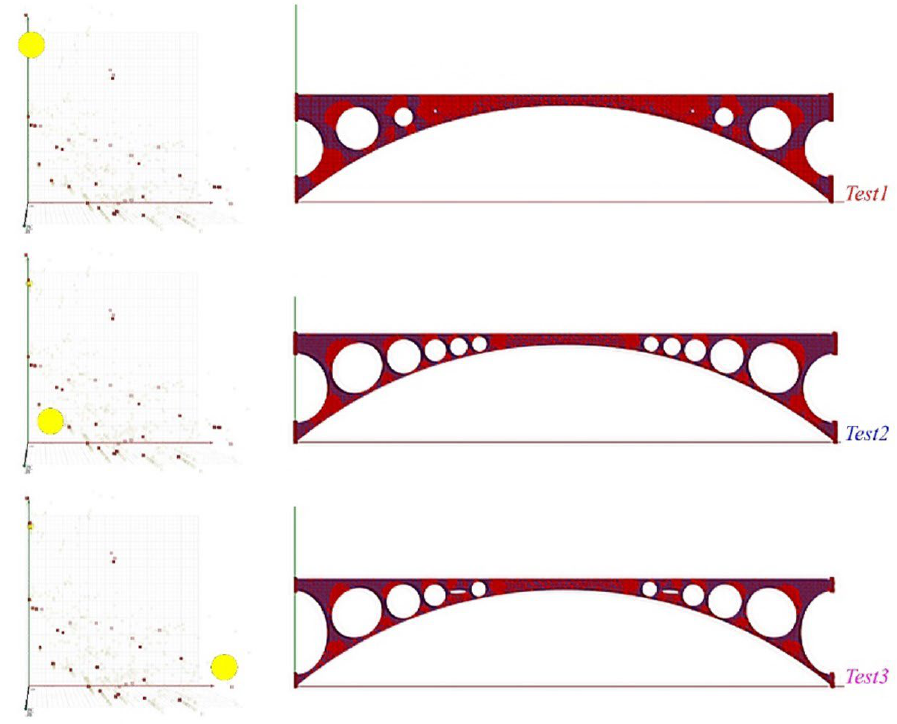
Figure 18. Pareto optimal front; in red, all feasible solutions.